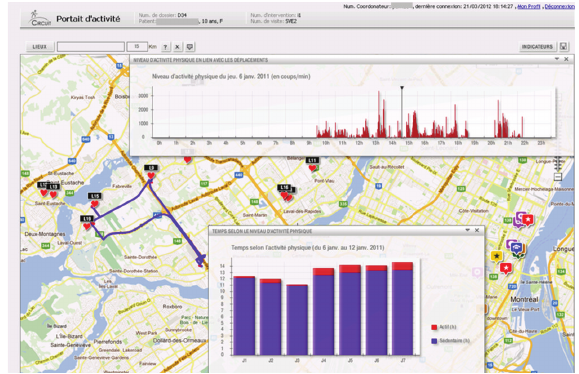
Figure 1: Interactive application for spatio-behavioural data visual- ization: patients’ residential neighbourhood and mapping of oppor- tunities.